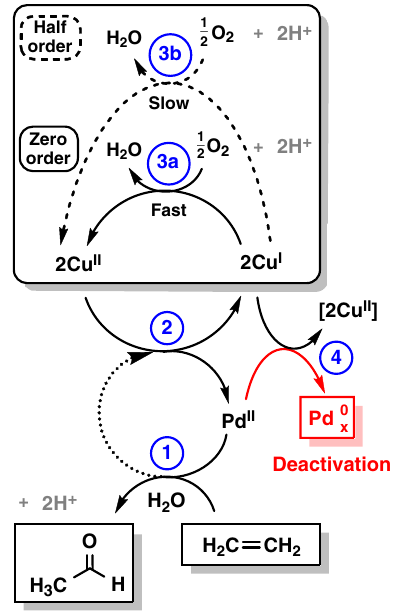
Fig. 5 Proposed mechanism for heterogeneous Wacker oxidation over Pd-Cu/Y. The catalytic cycle depicts the results obtained from this study. Reoxidation of palladium (Step 2) is represented by the dotted arrow. The activation of oxygen on copper (boxed) is depicted at high (solid arrow, Step 3a) and low (dashed arrow, Step 3b) oxygen partial pressures. The catalyst deactivation is shown in